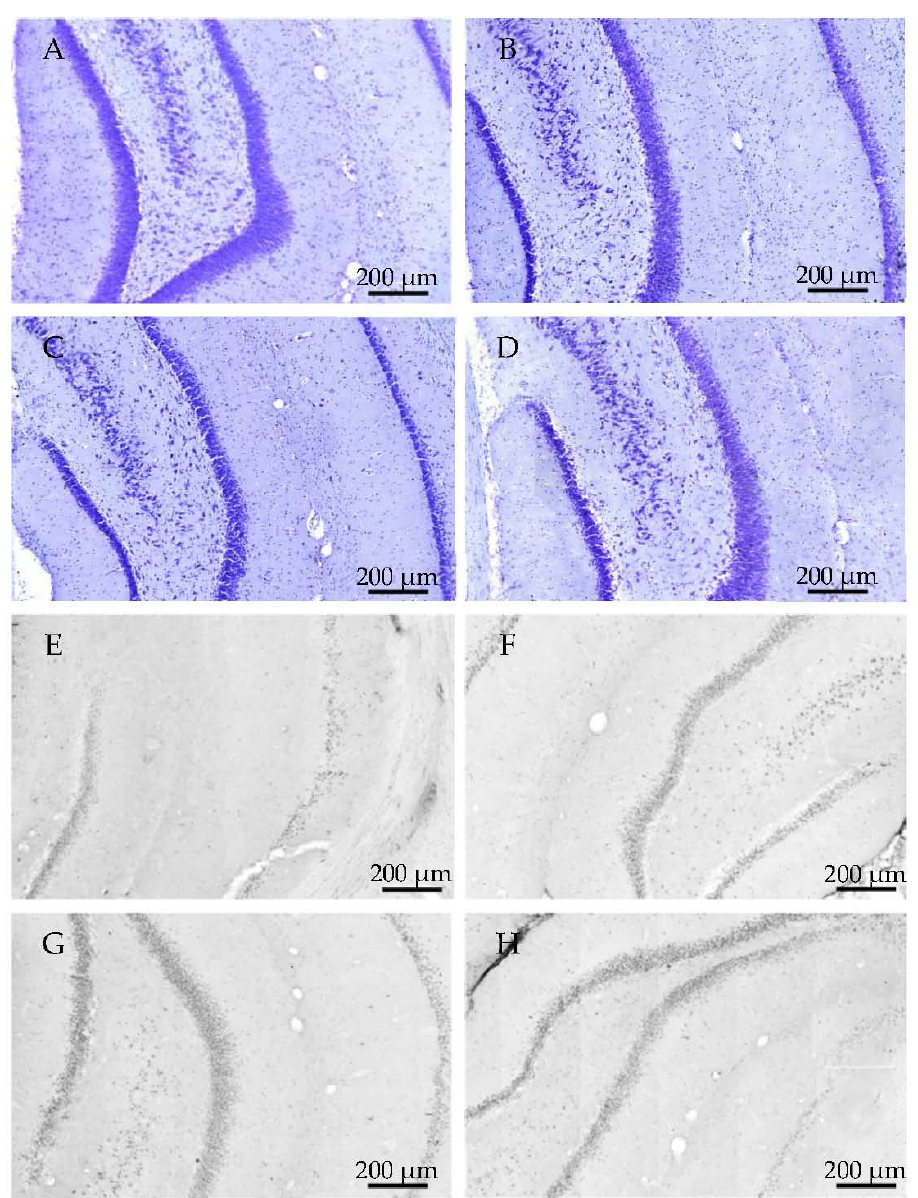
Figure 15. Representative examples of hippocampcal sections in 24 h aggregation groups, using cresyl-violet staining, show the change of viable neuron number ( A – D ). Immunochemistry with tau-antibody shows the presence of abnormally aggregated NFTs ( E – H ). ( A , E ): control group; ( B , F ): 25 µ M concentration; ( C – G ): 75 µ M concentration; ( D – H ): 200 µ M